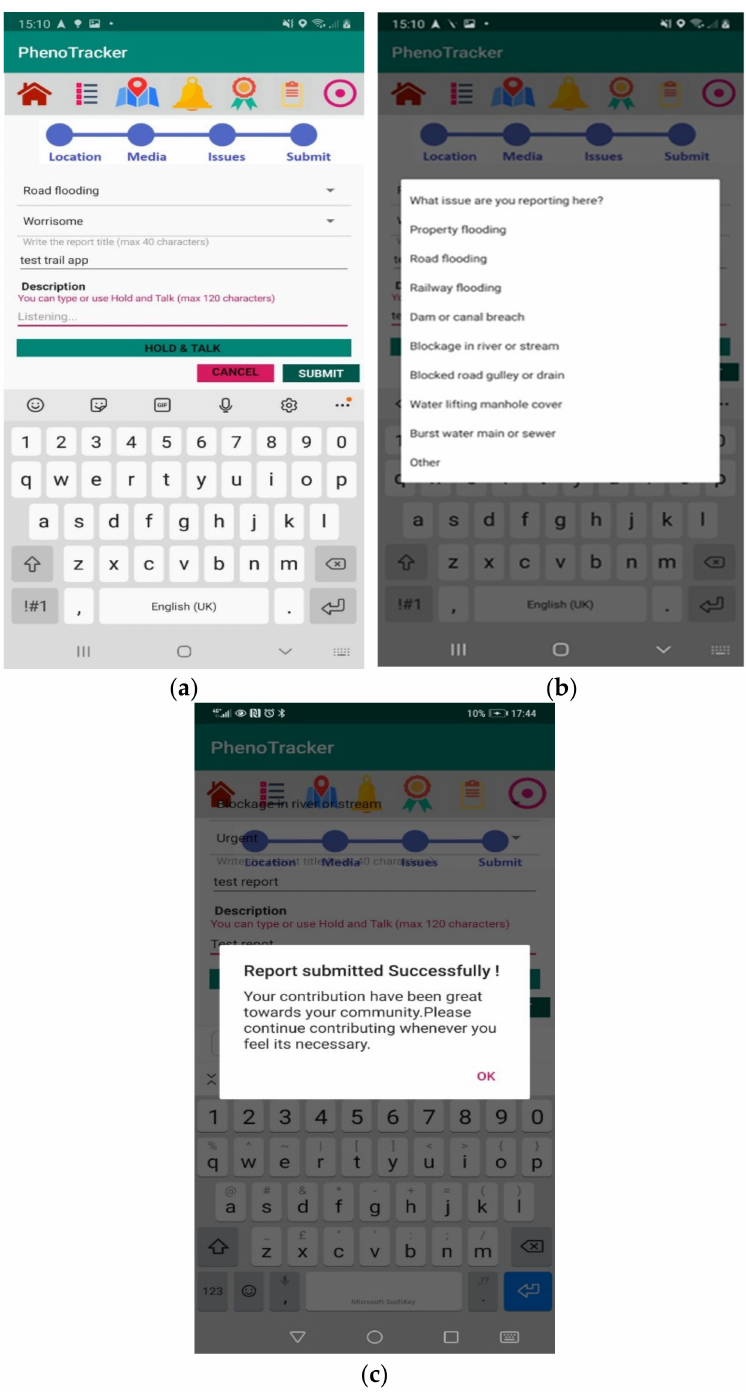
Figure 5. ( a ) Report description input fields with hold and talk feature (speech to text). Factors covered: UI, Altruistism, Situatedness and Contextual Clues. ( b ) Drop down option for report creation. Factors covered: UI, Altruistism, Situatedness and Contextual Clues. ( c ) Acknowledgment on report submission and contribution. Factors covered: Feedback, Altruistism and